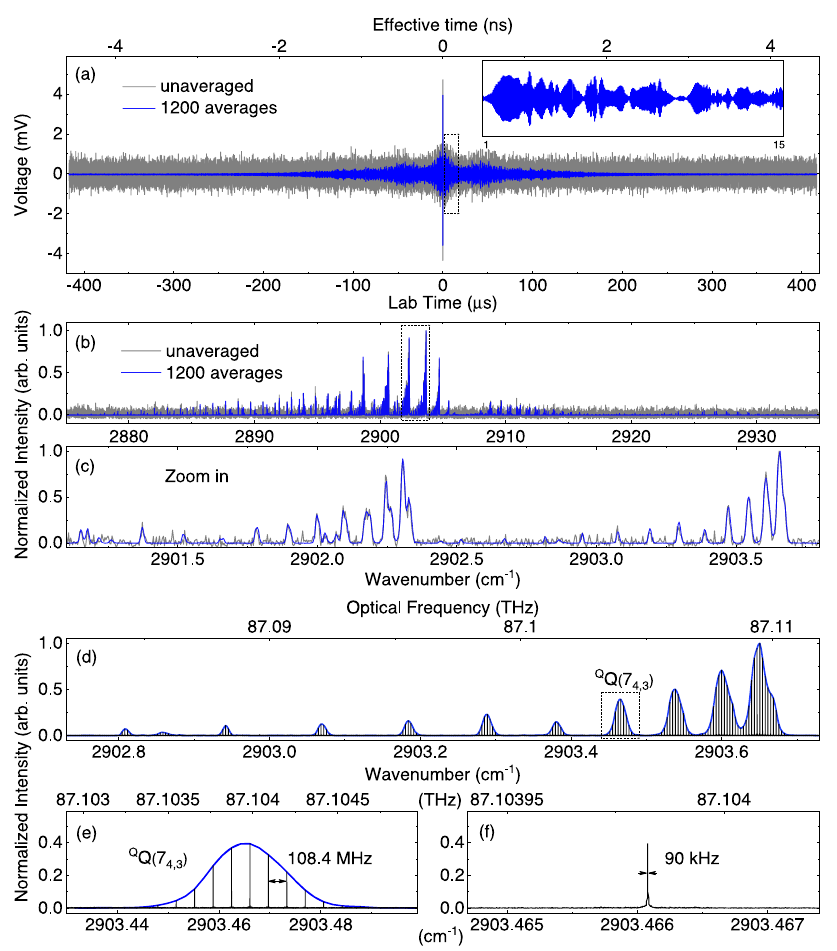
Fig. 2 | Experimental interferograms and mode-resolved DC-OAS spectra. a Comparison between the unaveraged and 1200-average interferograms within a singleperiod of 833 μ s;theinset plot is the induced-freedecayofmagneticoptical activity(MOA)within14 μ s. b SpectraoftheMOAsignalfor833 μ s(grayline)and1s (blue line) measurement times. c Partial spectra of b ranging from 2901cm − 1 to